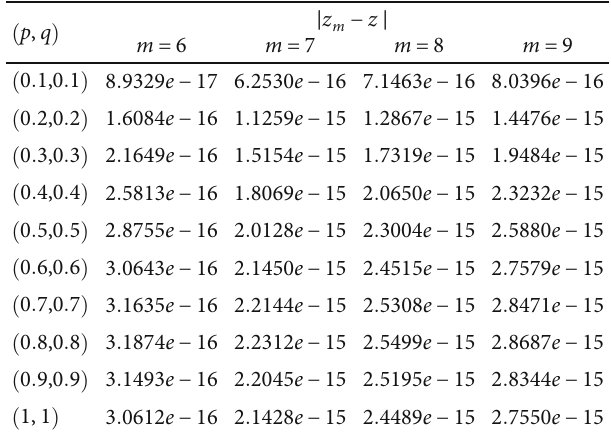
Table 1: The absolute error for di ff erent values m for Example 7 at various points ð p , q Þ